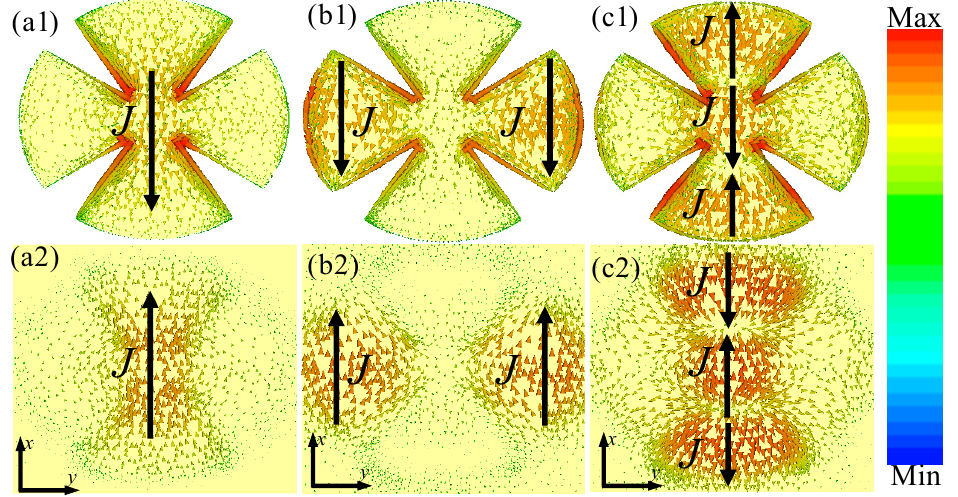
Figure 4. The surface current distributions of the ( a1 – c1 ) front and ( a2 – c2 ) back layer of the unit-cell structure at different resonant frequencies: ( a1 , a2 ) f 1 = 3.35 GHz; ( b1 , b2 ) f 2 = 8.65 GHz; and ( c1 , c2 ) f 3 = 12.44 GHz. The solid arrow indicates the flow directions of surface currents at two metallic layers.